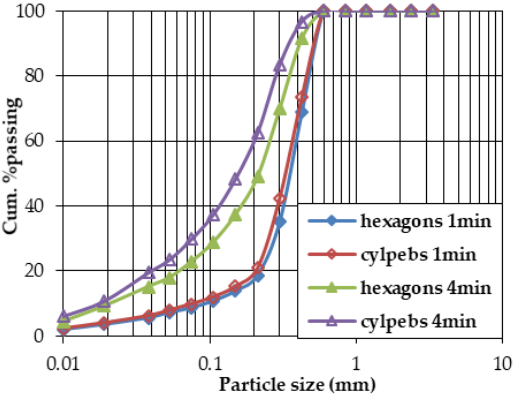
Figure 4. Size distributions of ground product using hexagons and cylpebs as grinding media. Figure 4 indicates that cylpebs and hexagons have a similar grinding particle size distribution.